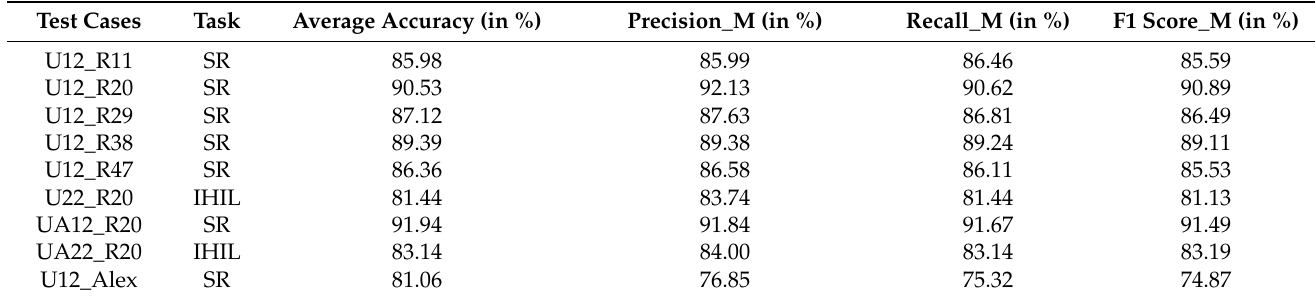
Table 6. Results of all test